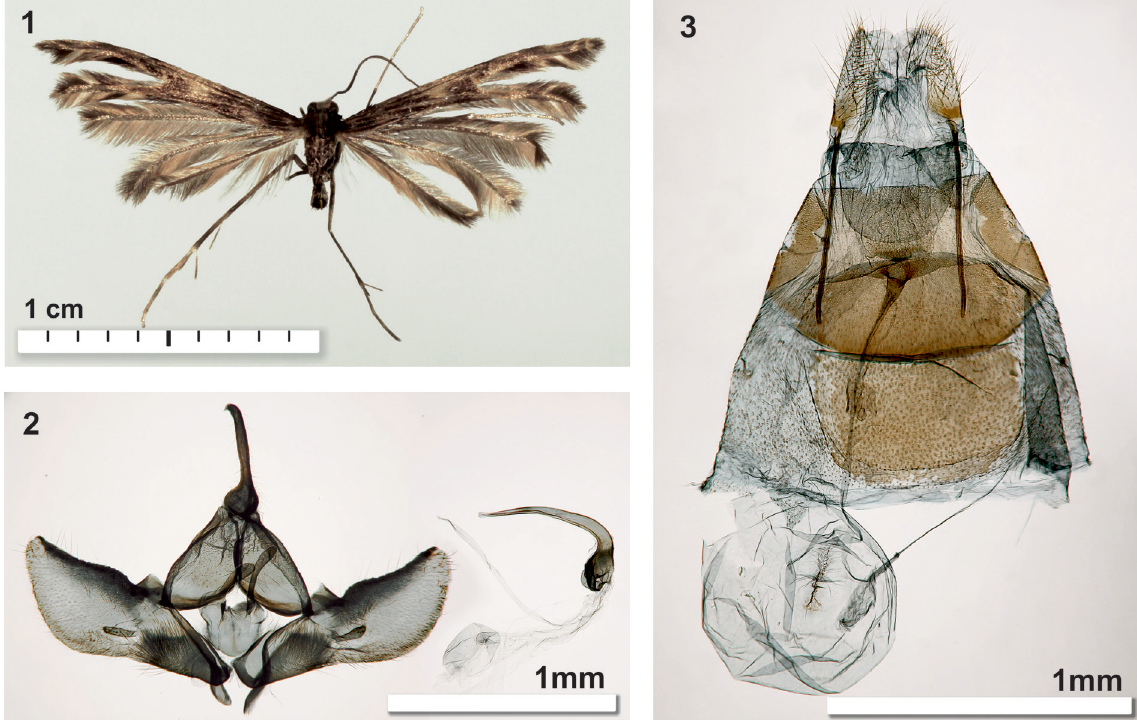
Figs 1–3. Singularia brechlini Kovtunovich & Ustjuzhanin sp. nov. 1 . Holotype (ZISP 1836). 2 . Holotype, genitalia (ZISP 1836). 3 . Paratype, ♀, genitalia (CUK